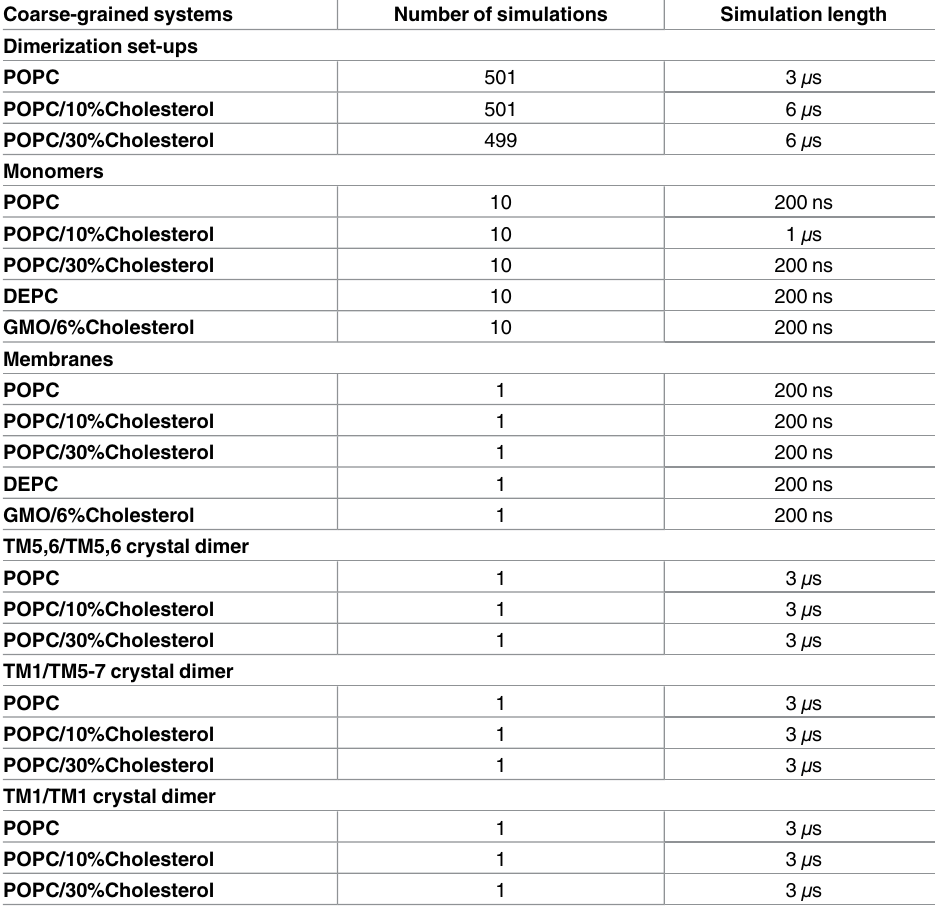
Table 1. Overview over all performed coarse-grained simulations.